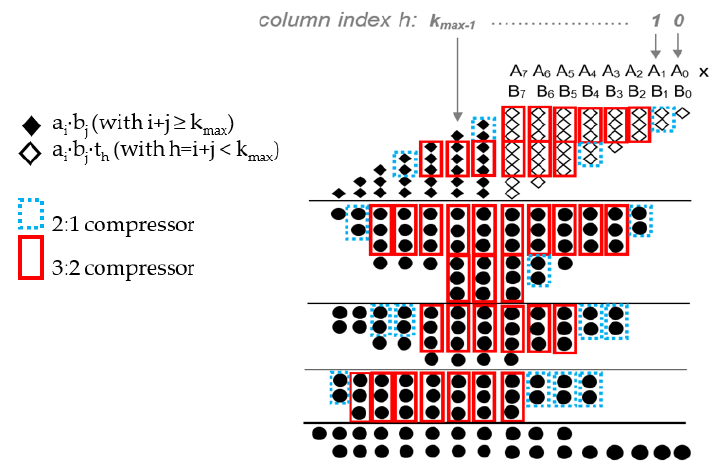
Figure 1. The dynamically truncated approximate multiplier [5].